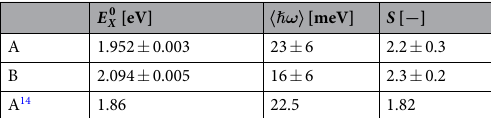
Table 1. Table of parameter values describing the exciton energy temperature dependence using equation (2). The bottom row shows previous measurements done without accounting for the trion contribution to the PL 14